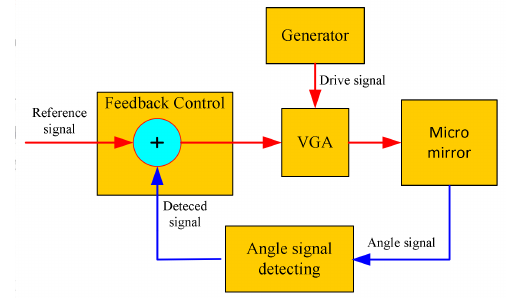
Figure 3. Closed-loop feedback control